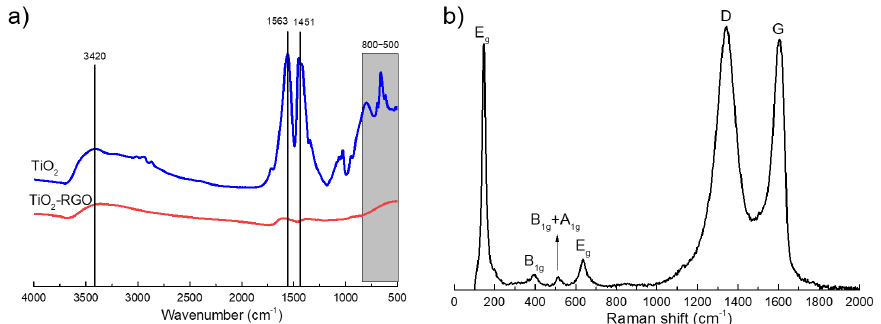
Figure 6. FTIR ( a ) and Raman spectra ( b ) of the TiO 2 -RGO nanoparticles.